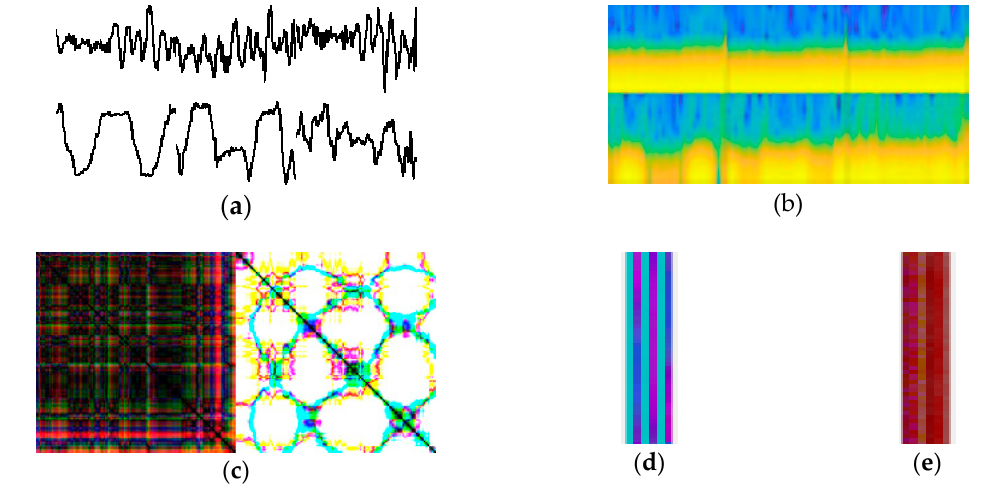
Figure 5. An illustration of activity images generated by ( a ) raw signal plot, ( b ) spectrogram, ( c ) recurrence plot, ( d ) multichannel, and ( e ) Iss2Image.